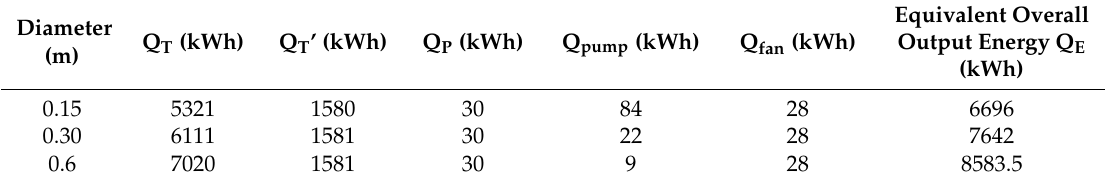
Table 4. Time − wise results of diameter study.